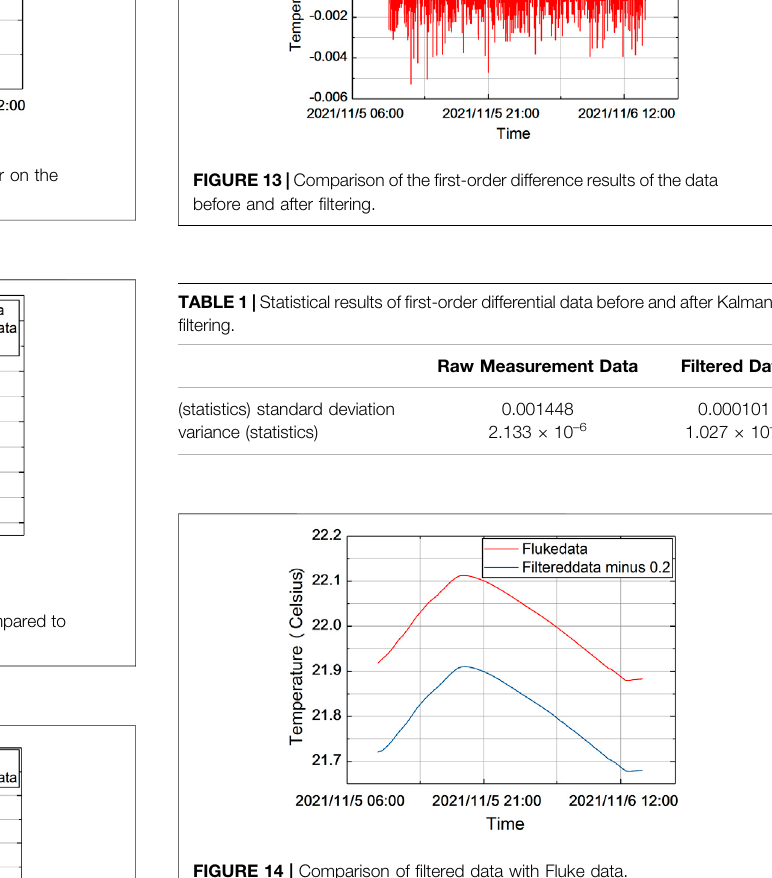
FIGURE 14 | Comparison of fi ltered data with Fluke